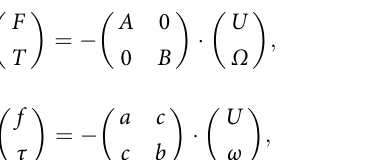
Fig. 5 Con fi nement enhances fl agellar thrust. Gray lines plot the time evolution of the speed as the cell exits the tightest microtunnel at the end of the structure. Circles represent mean values averaged over all the cells. Orange solid line is the best fi t with the model described in